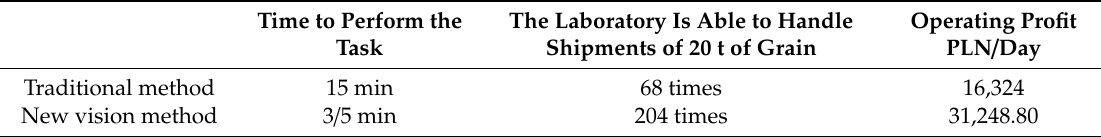
Table 2. The Profitability Analysis of the Project. Time to Perform the The Laboratory Is Able to Handle Task